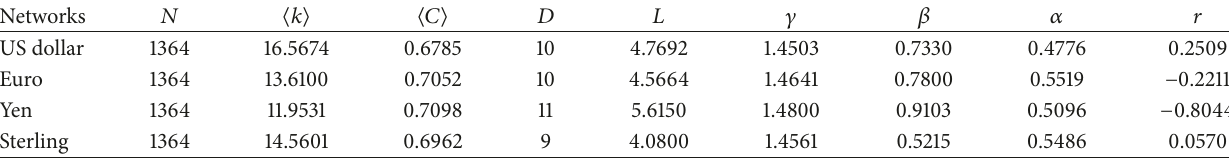
Table 1: Basic topological properties of the US dollar, Euro, Yen, and Sterling complex networks.